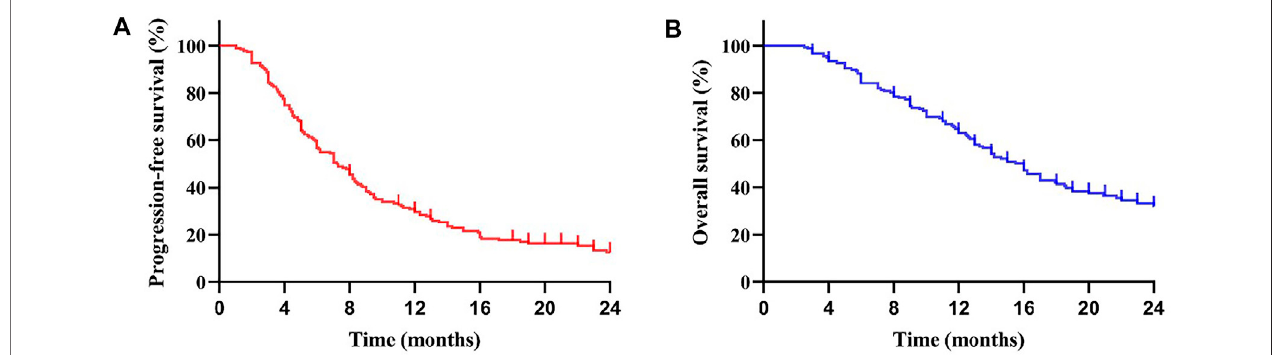
FIGURE 1 | Kaplan-Meier curve for progression-free survival (PFS) (A) and overall survival (OS) (B) of the patients: The mPFS was 7.0 months (95% CI: 5.69 – 8.31 months) in all subjects. The mOS was 16.0 months (95% CI: 14.17 – 17.83